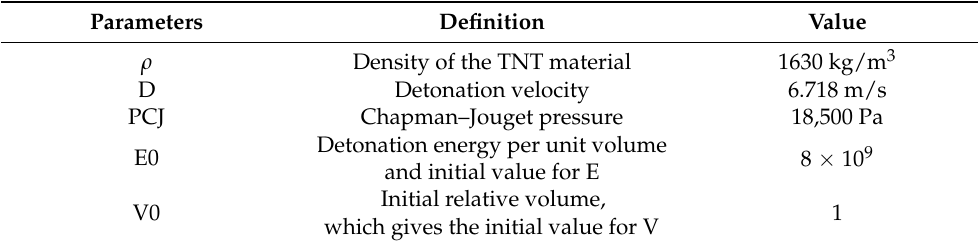
Table 1. Parameters of the TNT material model and the equation of state.